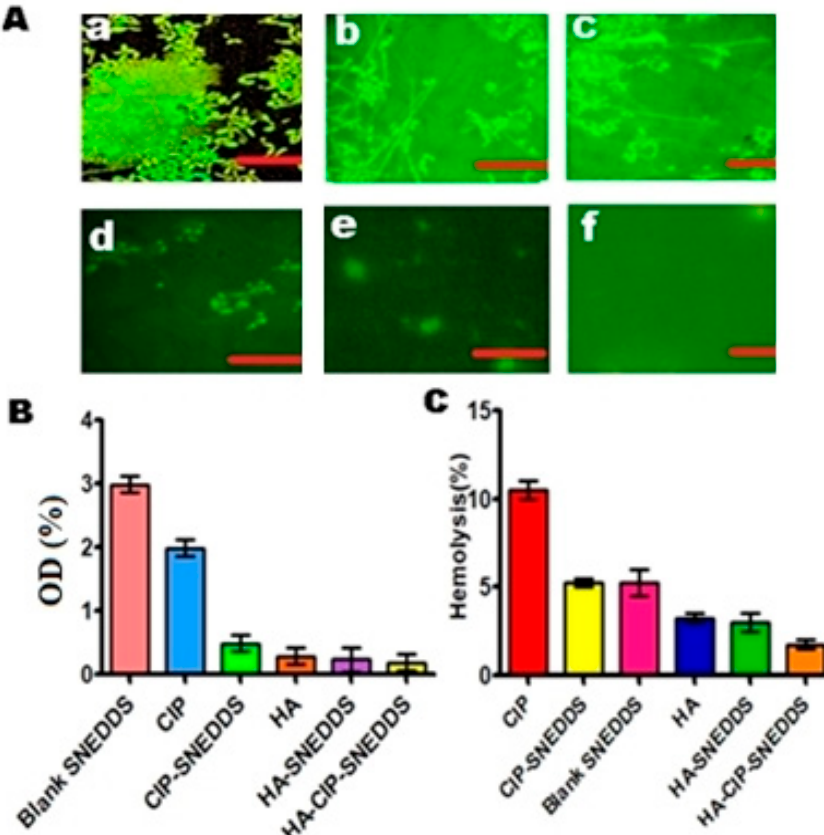
Figure 6. ( A ) Fluorescence imaging of FITC-tagged Salmonella typhi biofilms showing the Blank ( a ), CIP ( b ), CIP-SNEDDS ( c ), HA ( d ), HA-SNEDDS ( e ), and HA-CIP-SNEDDS ( f ) growth inhibition of biofilms by treating with SNEDDS (*Scale bars: 50 µm). ( B ) S. typhi biofilm dispersion graph of various formulations, ( C ) Determination in vitro hemolysis (%).